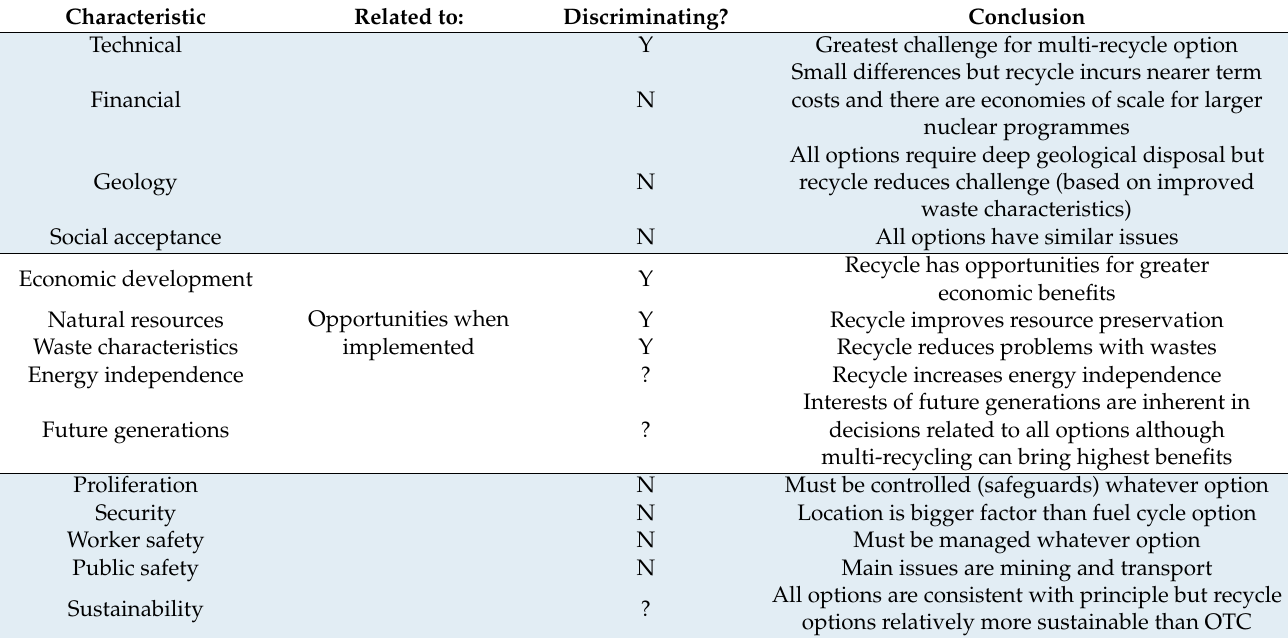
Table 13. Summary of factors affecting decisions on fuel cycle options defined by the OECD-NEA